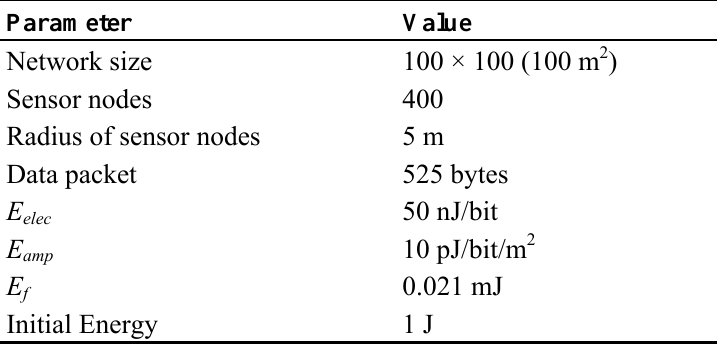
Table 1. System parameter for network